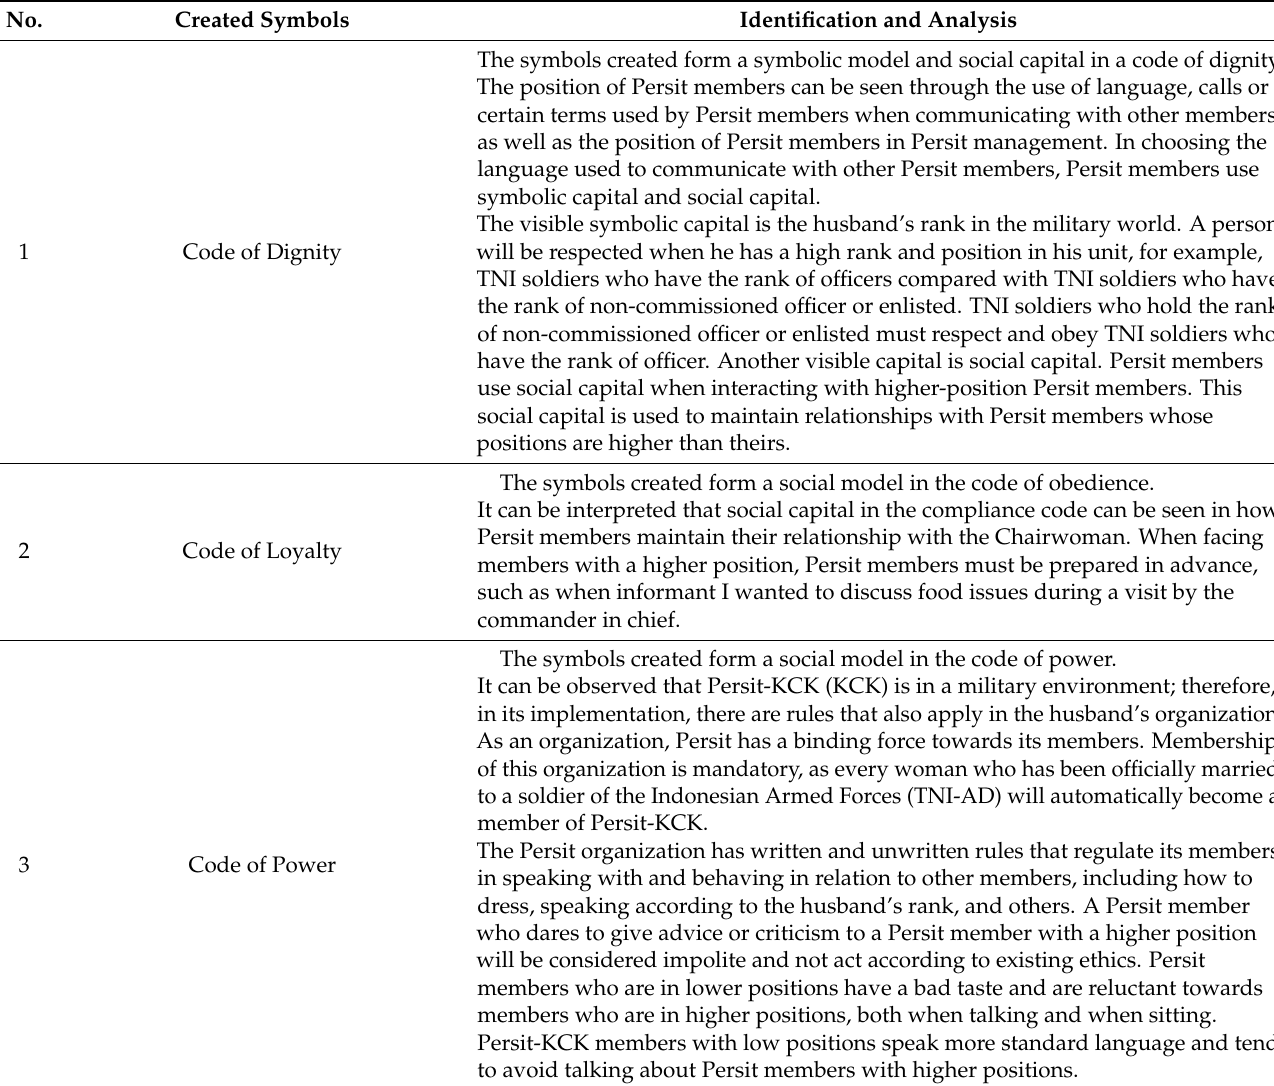
Table 2. Social identity and symbols that create